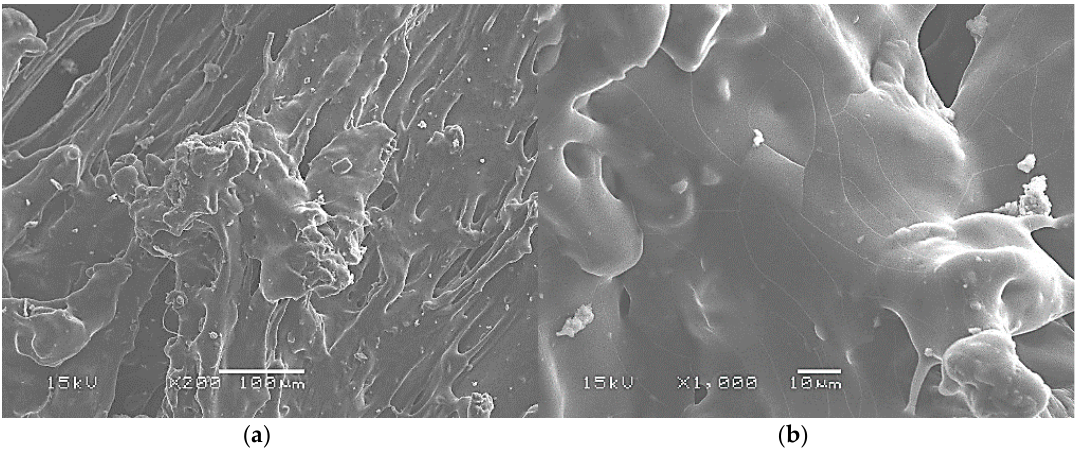
Figure 10. Potato starch-beet pulp composite foam SEM micrographs: ( a ) × 200; ( b ) × 1000.